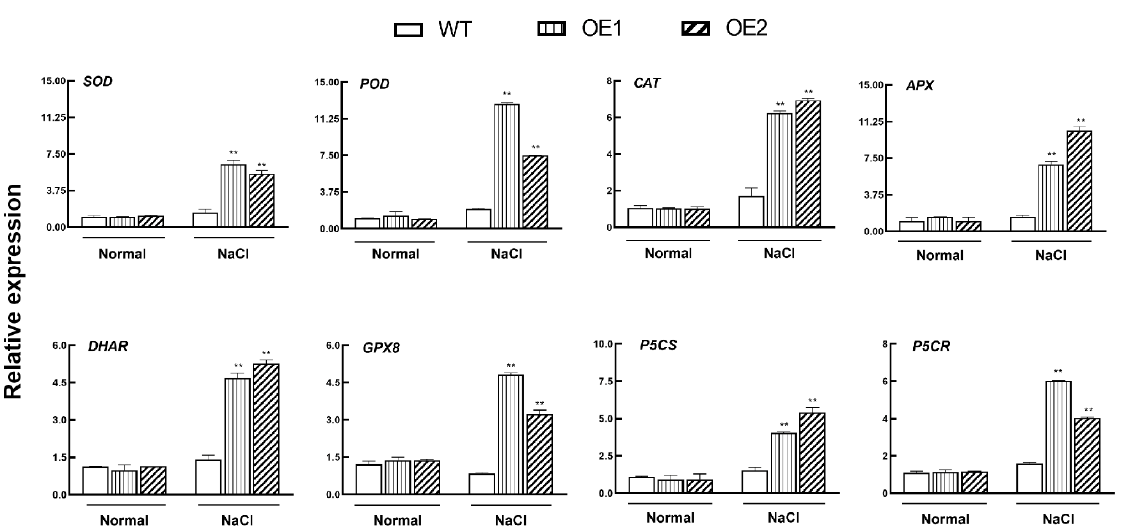
Figure 5. Expression analysis of genes involving in ROS scavenging under normal and high-salinity conditions in transgenic and WT plants. Data are presented as mean ± SE ( n = 3). ** indicates a significant difference at p < 0.01.